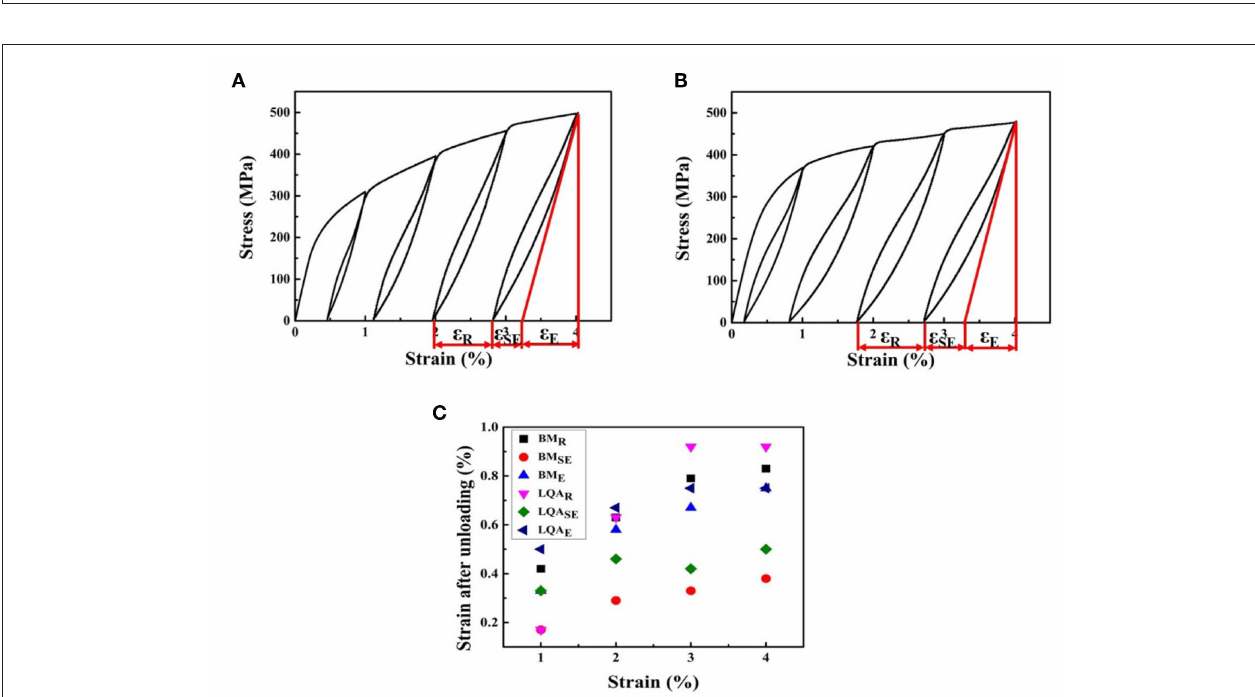
FIGURE 6 | Stress-strain curves of cyclic tensile tests of Ti-35Nb-2Ta-3Zr alloy: (A) base metal, (B) laser-quenched alloy, and (C) comparison of strain after unloading (BM, base metal; LQA, laser-quenched alloy).